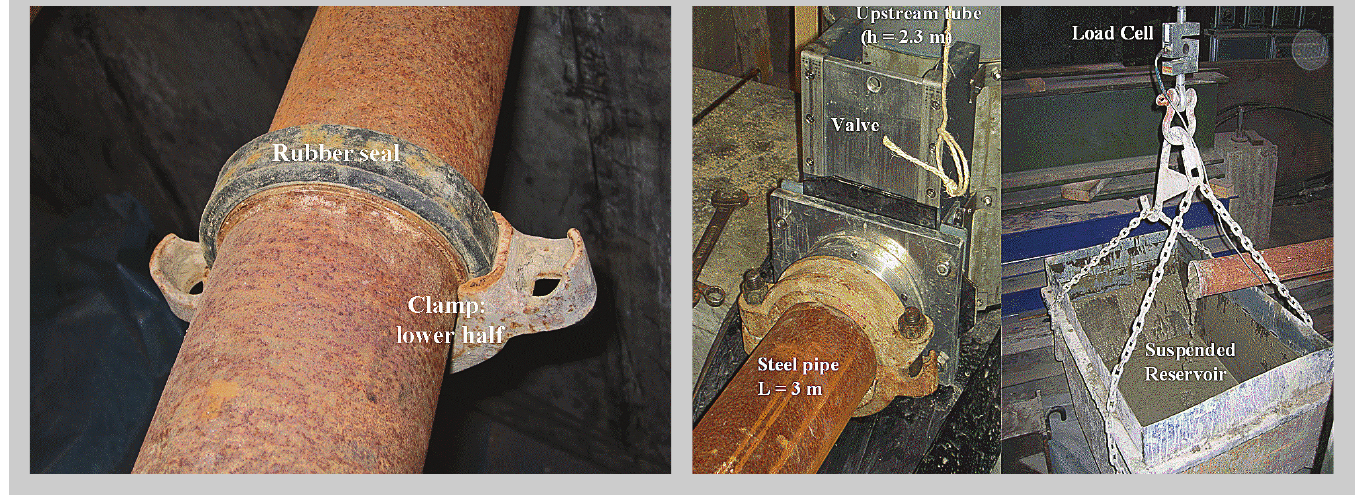
Figure 2 (left): Connection between pipes is established by clamps and is cement-paste tight by means of a rubber seal. Figure 3: Flow-test setup. Left: Upstream reservoir with valve and the first horizon- tal steel pipe. Right: Down- stream reservoir, suspended to a rolling bridge by means of load